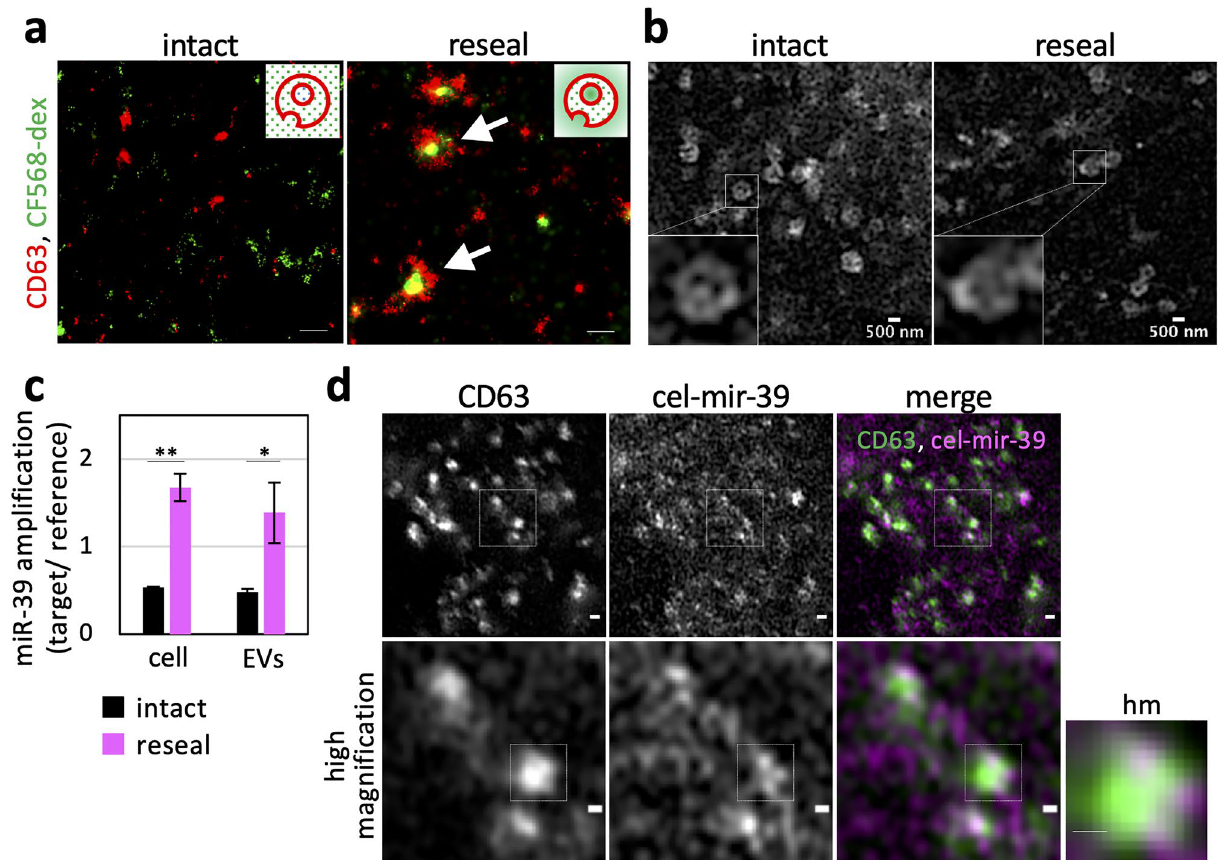
Figure 2. Encapsulation of exogenously added soluble cytosolic materials into ILVs and EVs in resealed HeLa cells. ( a ) Super-resolution images showing encapsulated 10 kDa CF568-labeled dextran (CF568-dex) in an intraluminal vesicle (ILV)-like structure. After introducing cytosol containing 100 µg/mL of CF568-dex, intact and resealed HeLa cells were post-incubated for 120 min and subjected to immunofluorescence (IF) analysis using anti-CD63 antibody (− SLO as “intact” and + SLO as “reseal”). The cells were observed by using an N-STORM super-resolution system. Green and red represent CF568 and CD63 signals, respectively. Arrows indicate CF568-dex incorporated in ILV-like structures. Inset: supposed models of ILV-like ultrastructure on background noise signals (dots). Scale bar = 200 nm. ( b ) Super-resolution images showing similarity of the ultrastructure of MVEs between intact and resealed HeLa cells. HeLa cells were incubated in DMEM without phenol red and observed using LSM980 with Airyscan2 at 37 °C (live-cell imaging). Inset: similar MVE-like ultrastructure observed in both intact and resealed HeLa cells. ( c ) Quantification of the amount of exogenously added synthesized miRNA in whole cells and EVs. The bar plot shows the relative amount of cellular- and EV-miRNA. After introducing cytosol containing a 1.0 nM synthesized cel-miR-39, intact and resealed HeLa cells were post-incubated for 120 min and further incubated in a 5% CO 2 incubator for 48 h at 37 °C. Total cellular- and EV-RNA were extracted and miR-39-3p (guide strand) amount was measured by real-time PCR. Fluorescent signal values of the target (FAM) were normalized by those of references (ROX). Data represent results from three independent experiments ( n = 3), expressed as the mean ± SD. * P < 0.05; ** P < 0.01. ( d ) Super-resolution images showing Cy3-labeled miR-39-3p in the MVE-like structure. After introducing cytosol containing a 1.5 µM fluorescently labeled double-stranded miRNA mimic (Cy3 for cel-mir-39, guide strand; Cy5 for cel-mir-39*, passenger strand), resealed HeLa cells were post-incubated for 120 min and subjected to IF analysis using anti-CD63 antibody. The cells were observed using an LSM980 with Airyscan2. Arrows indicate miRNA accumulated in MVEs. The right panels are a magnified image of the white boxes in the left panel. hm: high magnification. Scale bar (upper images) = 500 nm. Scale bar (bottom images and cropped images) = 200 incubator for 120 min at 37 °C and subjected to IF analysis using anti-CD63 antibody. CD63 is expressed in various organelles (e.g., late endosomes, lysosomes, plasma membrane, other organelles), and it is particularly enriched in MVEs or ILVs 30 . As a control, we incubated intact HeLa cells with CF568-dex for 25 min in advance. ILVs immunostained with anti-CD63 antibodies in resealed HeLa cells were observed using super-resolution microscopy. The green CF568 signals appeared encapsulated in red dotted CD63 in resealed HeLa cells, while we observed little co-localization of CF568 spots with CD63 in intact HeLa cells (Fig. 2a). In our study, CF568- positive dots were distinguished from those labeled with endocytosed CF568 in intact HeLa cells topologically.